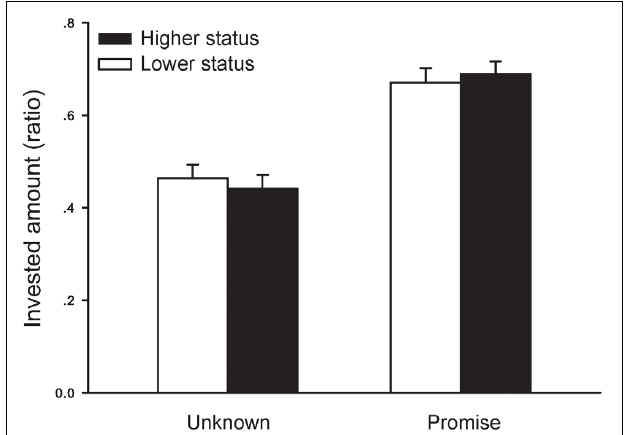
FIGURE 2 | Mean and standard error of the means for ratio of investment in partners of different social status across the two promise conditions (“unknown” vs.